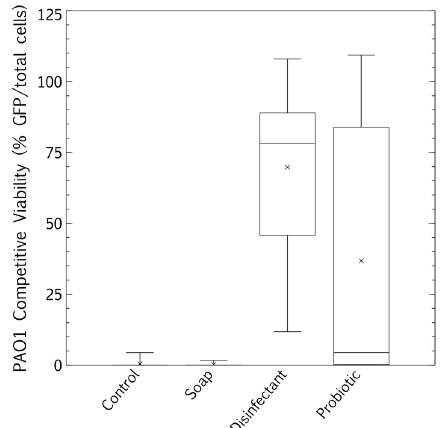
Figure 5. Biofilm proliferation of Pseudomonas aeruginosa -GFP in competition with the resident surface microbiome assessed between cleaning regimes (tap water, plain soap, disinfectant, and probiotic cleaner) using confocal microscopy. Post-desiccation competitive biofilm growth was calculated as % pathogen (green, P. aeruginosa ) over the total microbiome (blue, Hoescht 537). Box and whisker plots represent averages of three flow cells, three images per flow cell (nine images per treatment, three biological replicates, all images at least 1 cm distant from each other).